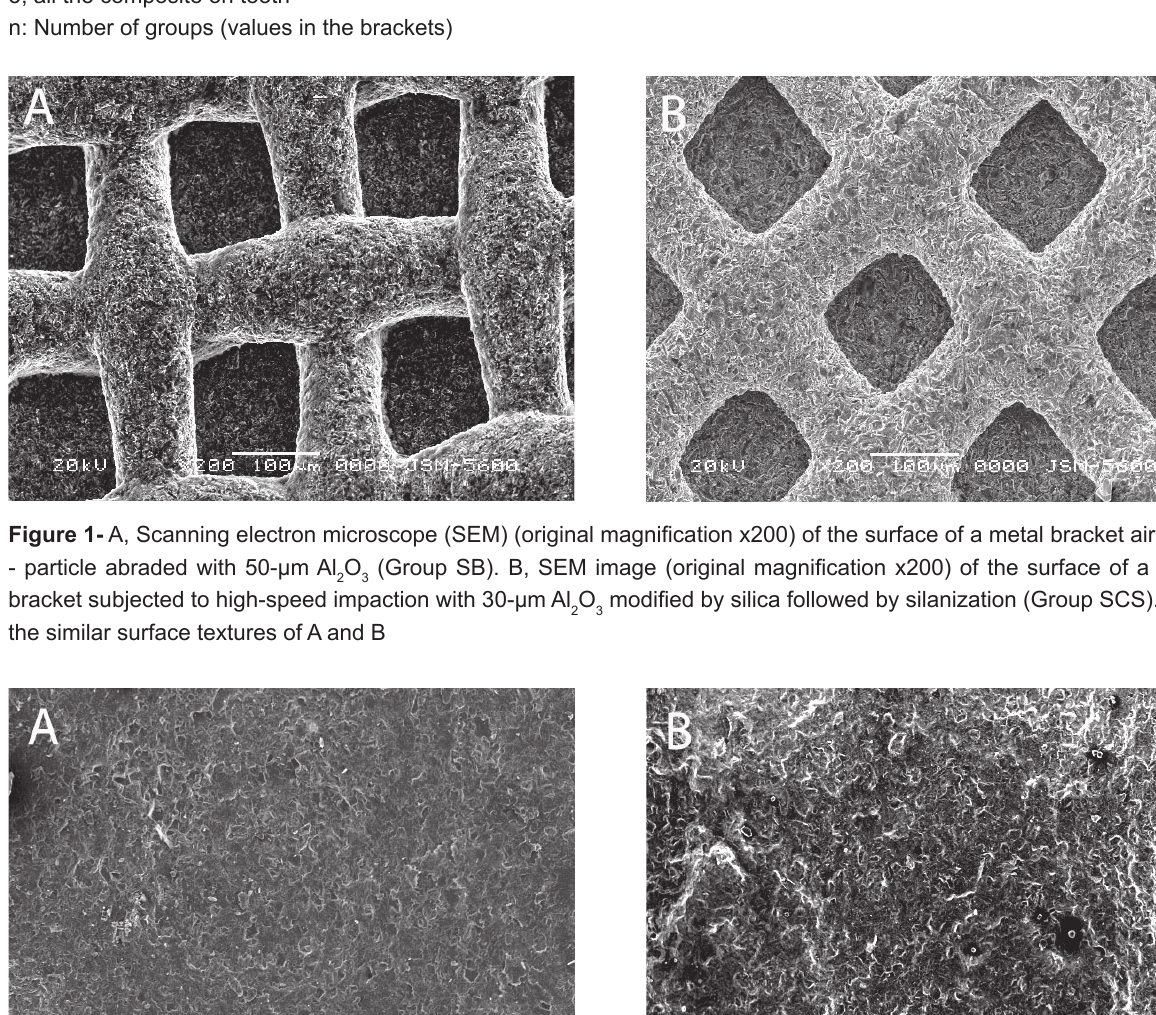
O (Group SB). B, SEM image (original magnification x100) of ceramic 2 3